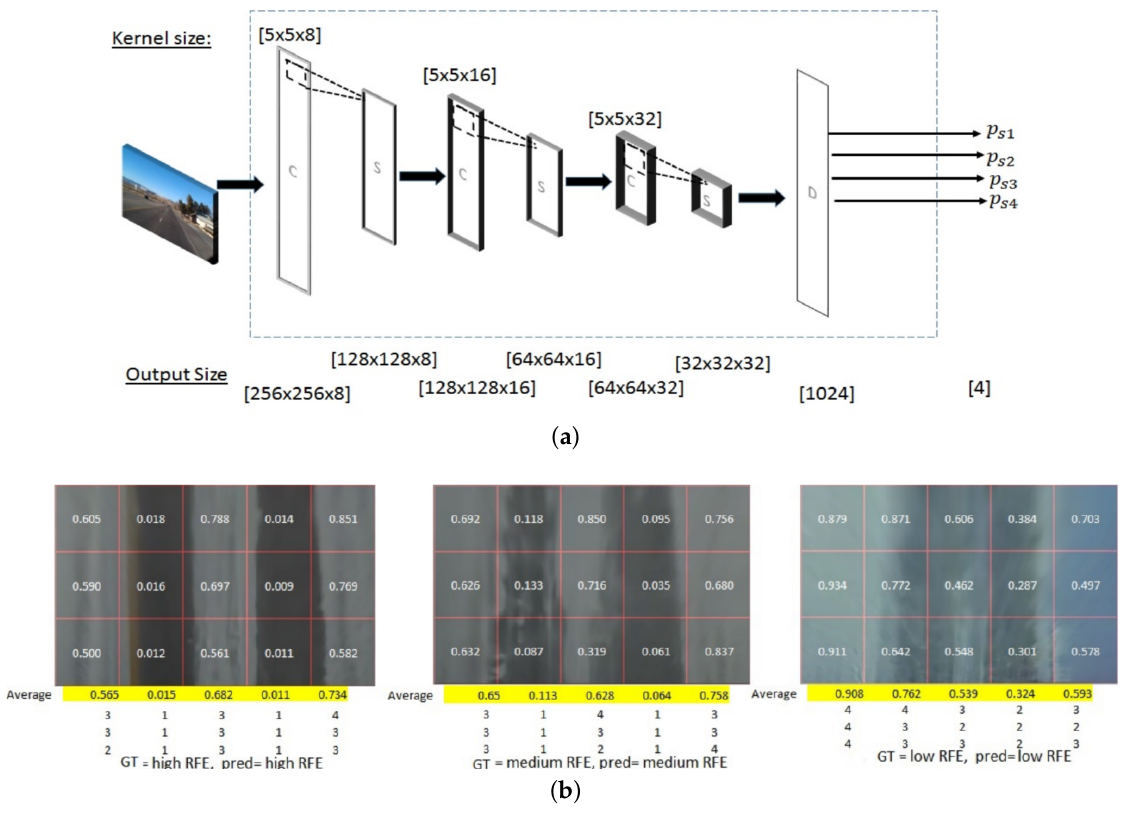
Figure 11. ( a ) Example of convolutional neural network architecture with three continuous convolution/sub-sampling C-S layers (CS3) followed by four output class dense D flattening layers. ( b ) Example of road chunking quantisation and road reflectance classification results